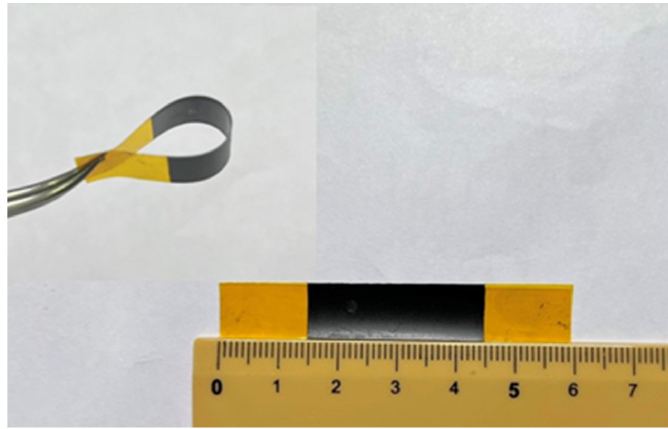
Figure 2. Flexible nanomaterial film deposited on a PI substrate.